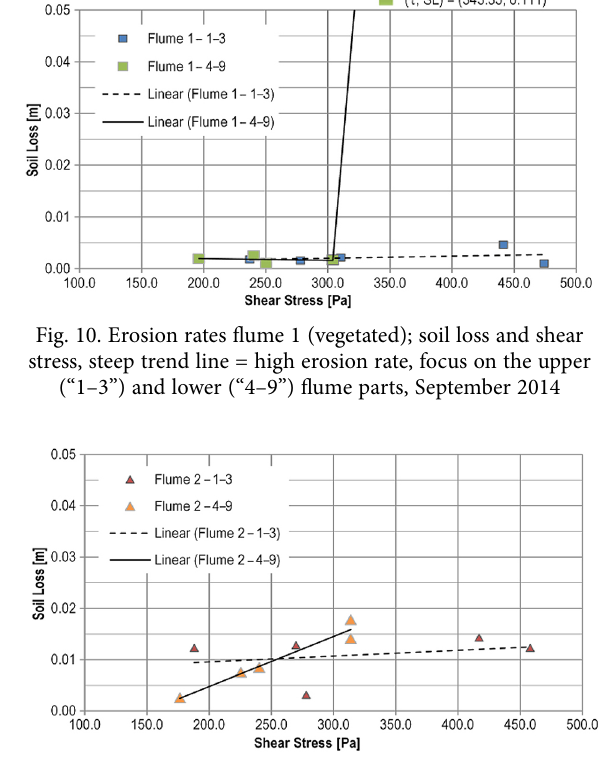
Fig. 14. Erosion rates flume 2 (unvegetated); soil loss and shear stress, steep trend line = high erosion rate, focus on the upper (“1–3”) and lower (“4–9”) flume parts, September 2014